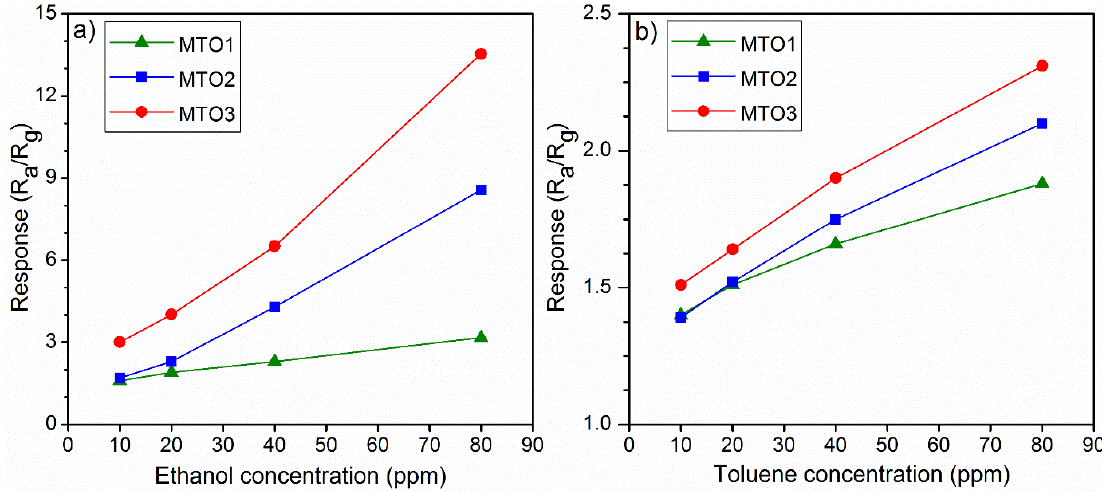
Figure 10. Response of Mg-doped SnO 2 films vs. ( a ) ethanol and ( b ) toluene concentration at 160°C.